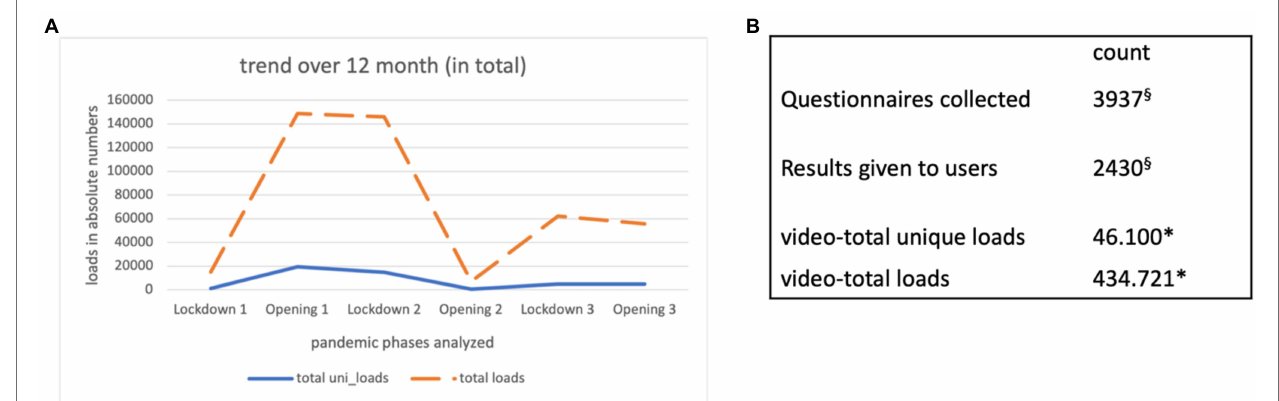
FIGURE 4 | QR codes for App download and website access data collected during the first year of operation of the fully functional website. (A) The different time phases analyzed were lockdown 1 (March 18th, 2020 (data collection started April 1st 2020)–April 29th 2020), opening 1 (May 1st 2020–November 2nd 2020),